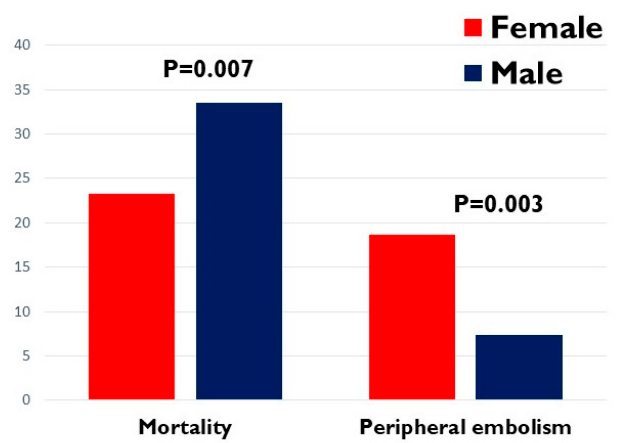
Figure 2. Mortality and peripheral embolism according to gender. Histograms demonstrating the different mortality and peripheral embolism incidence in female and male patients.